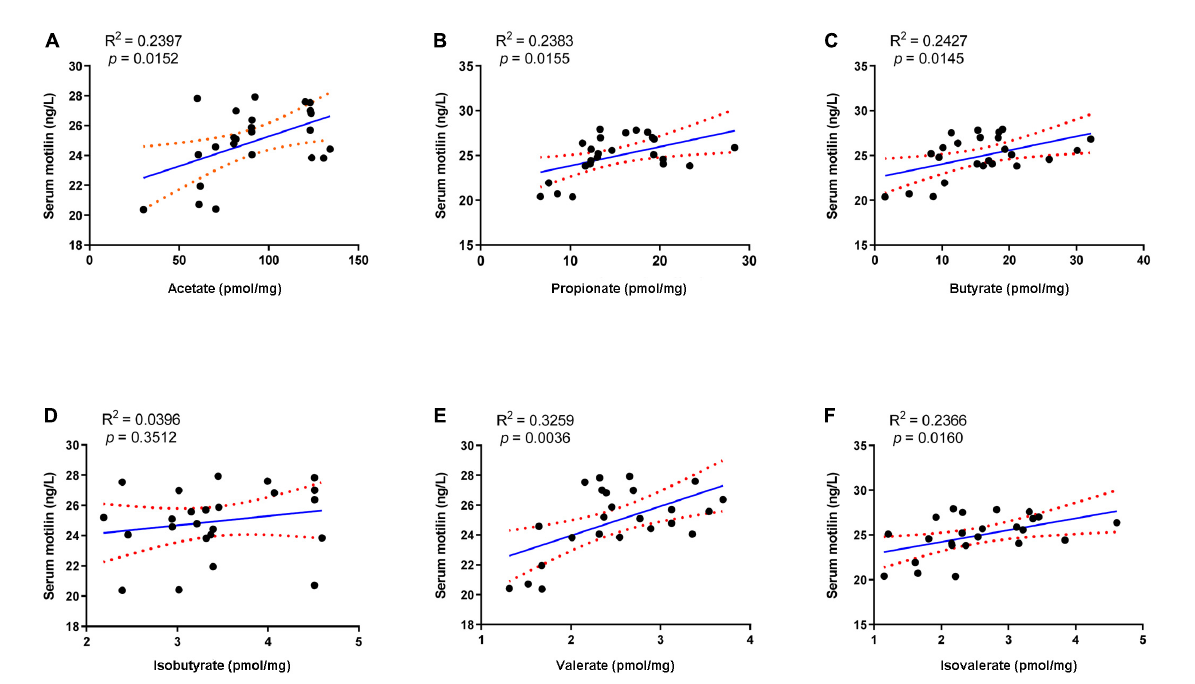
FIGURE7 Linear regression analysis between serum motilin level and (A) acetate, (B) propionate, (C) butyrate, (D) isobutyrate, (E) valerate, and (F)